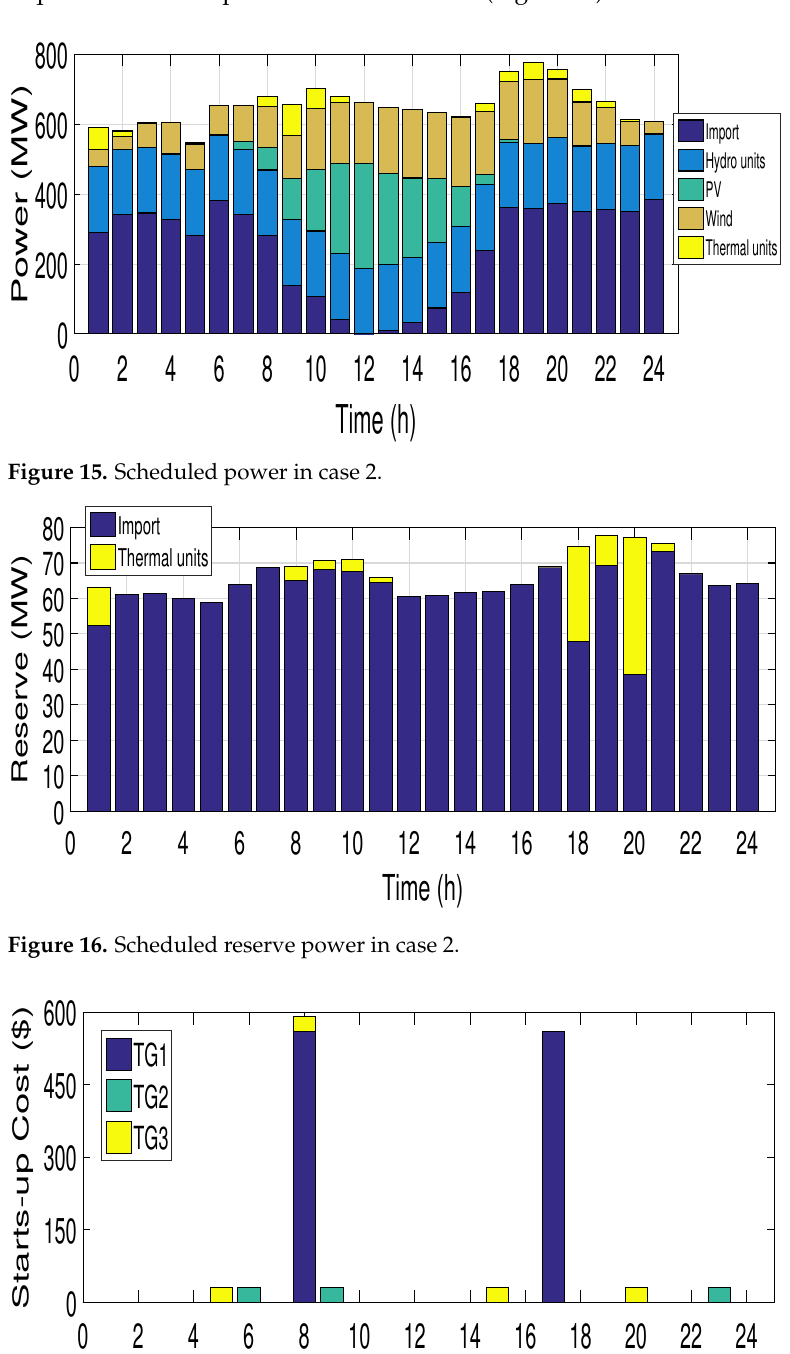
Figure 17. Starts-up cost of thermal units in case